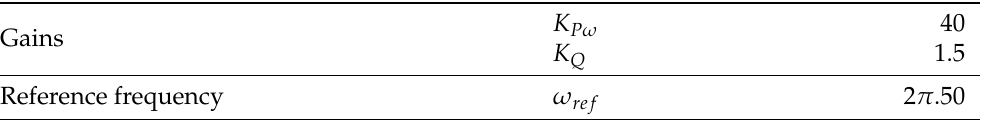
Table 3. Control parameters of secondary controller in Figure